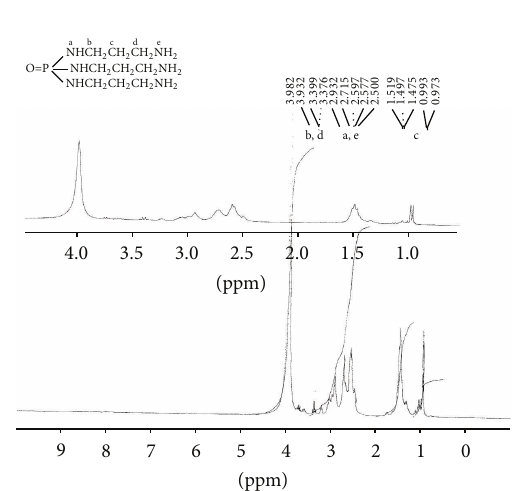
Figure 4: FT-IR spectra of TPDAP.